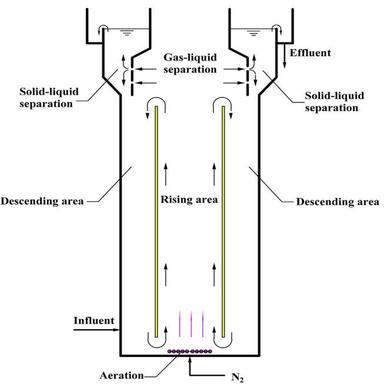
Schematic diagram of the up-flow biological fluidized bed reactor.